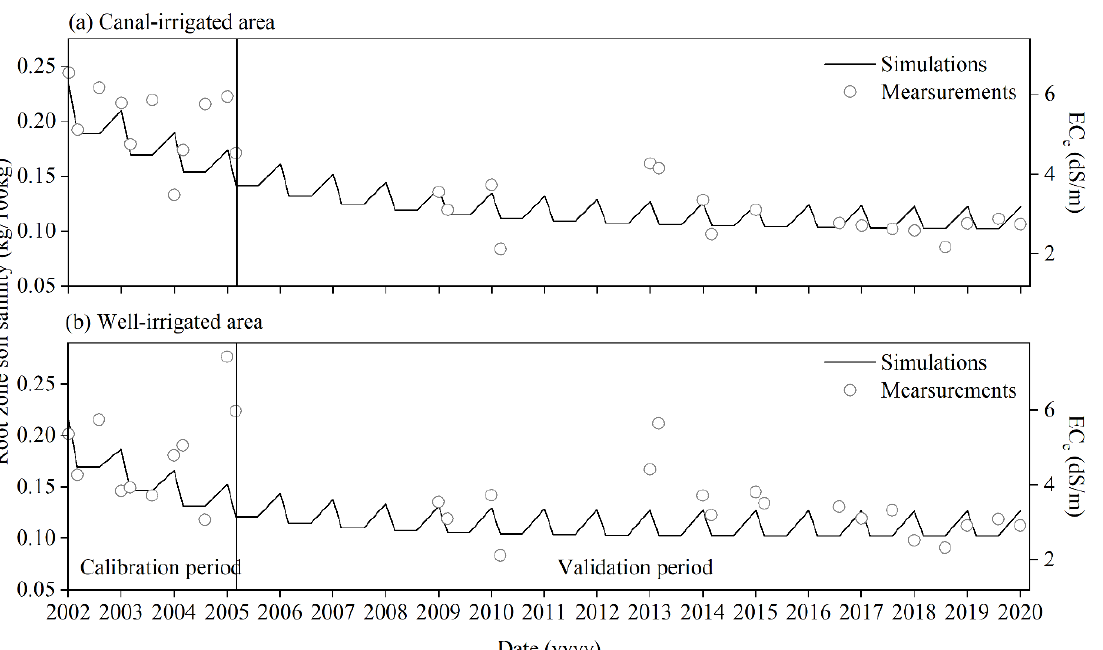
Figure 8. A comparison of results of simulated and observed root zone soil salinities of the Longsheng well-canal conjunctive irrigation area during the calibration and validation periods. Table 4. Model calibration results obtained by comparing the simulated and measured water table depths and root zone soil salinities.